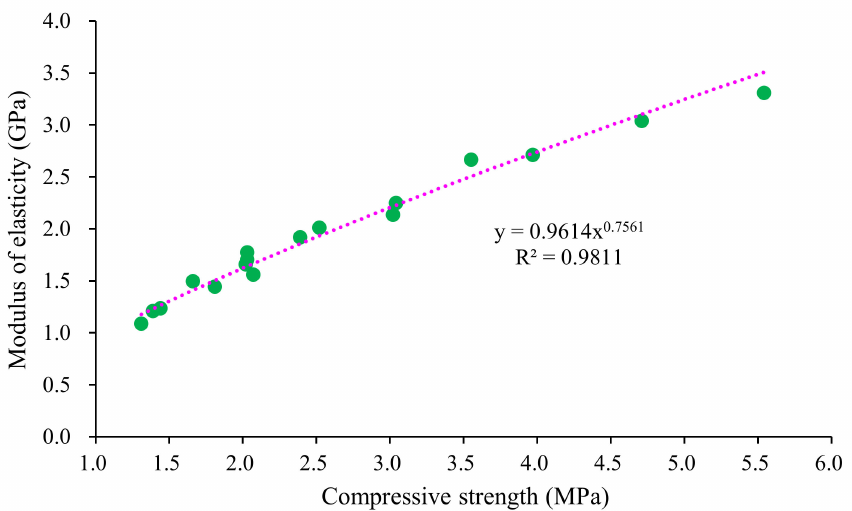
Figure 10. Relationship between elasticity modulus and compressive strength of the